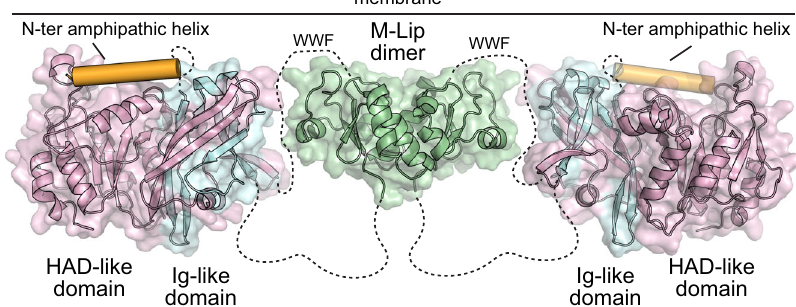
Fig. 6 Structural model of mammalian lipin PAPs. Proposed model for a dimeric lipin 1 protein with the N-Lip (blue) and C-Lip (pink) combining to form the Ig-like and HAD-like domains. Membrane association is driven by multi-valent interactions from the N-terminal amphipathic helix (orange), the active site of the HAD-like domain, regions of the Ig-like domain, and the dimeric M-Lip that contains a hydrophobic WWF motif that is fl anked by basic